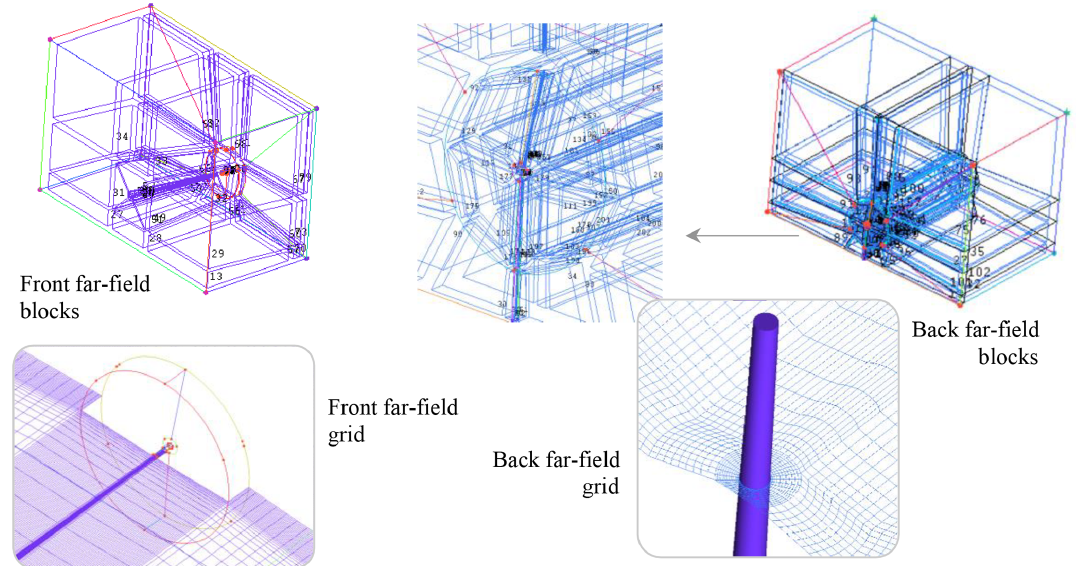
Figure 4. Front and back far-field